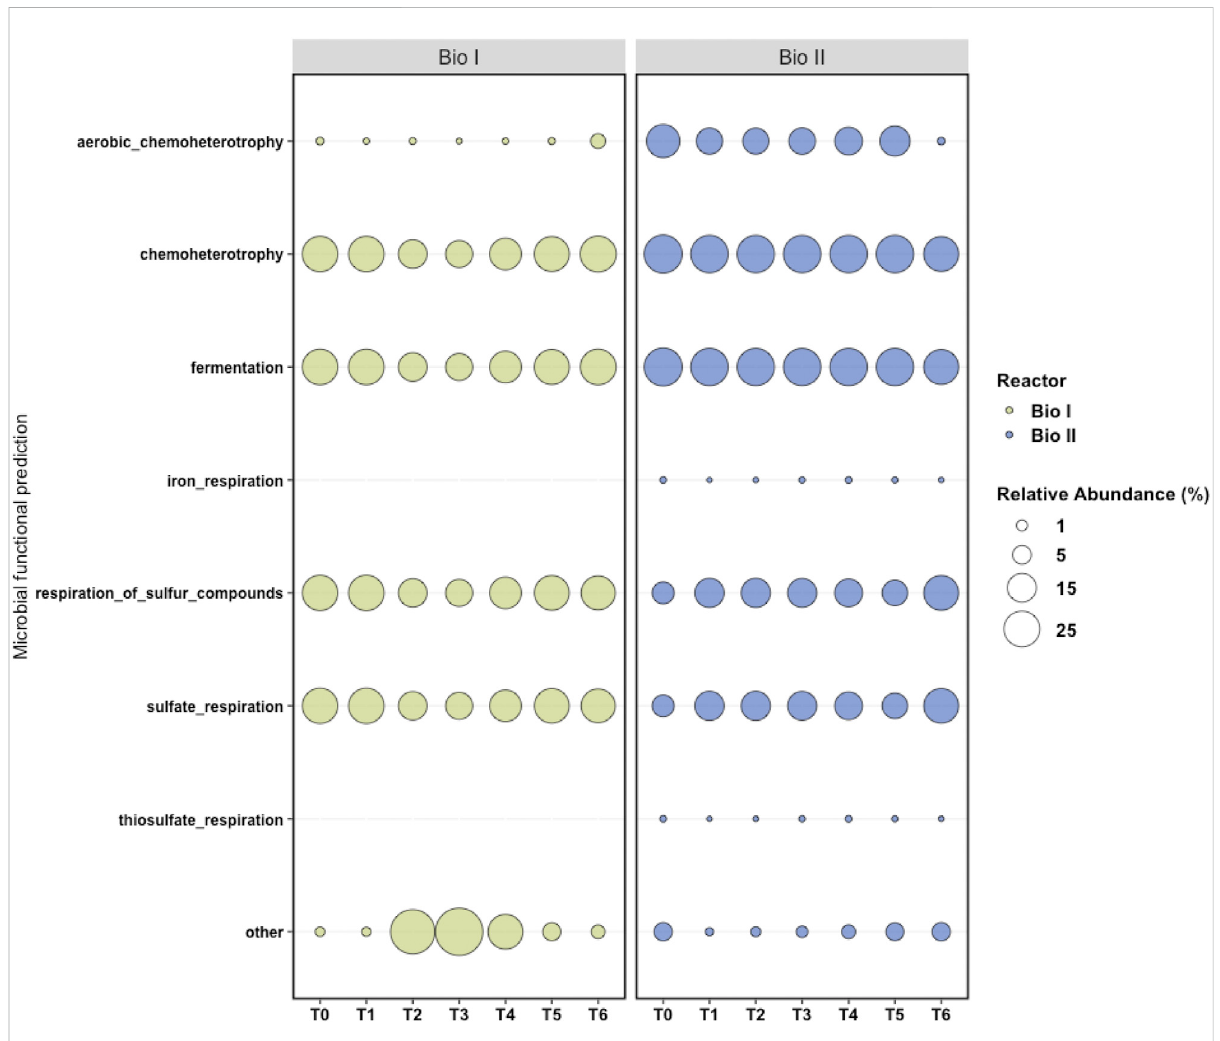
FIGURE 6 Metabolic maps generated by FAPROTAX. FAPROTAX converted taxonomic data at the level of genus and species generated by QIIME2 into functional pro fi les. Each column represents a sample (T0 to T6) and each line a metabolic function. In the graph, other represents the proportion of microorganisms that did not have the identi fi ed physiological